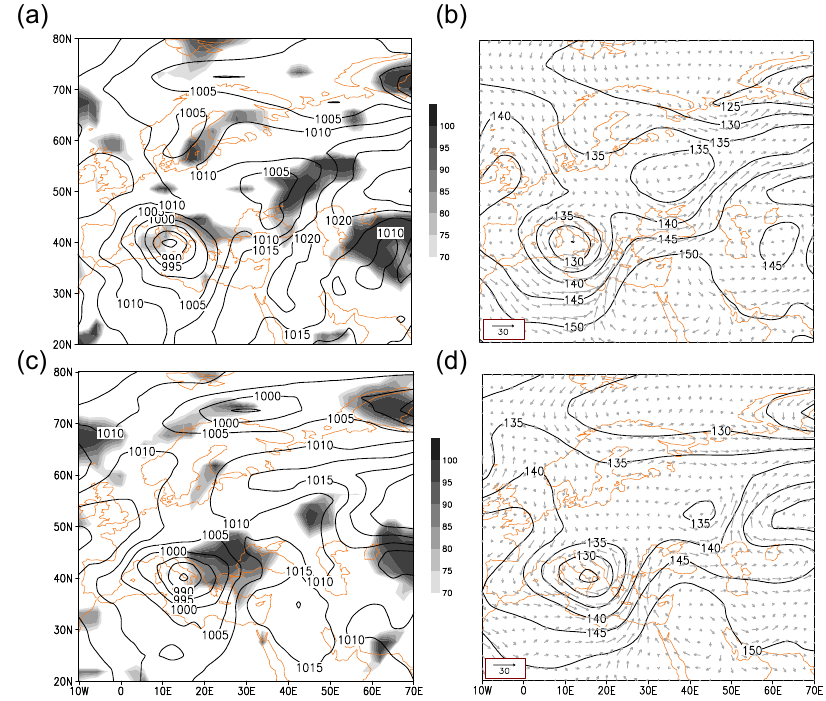
Figure 6. The evolution of the first dust storm event over Turkey at 00:00 UTC 23 March 2016. ( a ) sea level pressures (solid lines, every 5-hPa), and total cloud cover (shaded, %) at surface. ( b ) Height (solid lines, dam) and winds (m·s − 1 ) at 850-hPa. ( c ) same as ( a ), and ( d ) same as ( b ) but for 12:00 UTC of the 23 March.